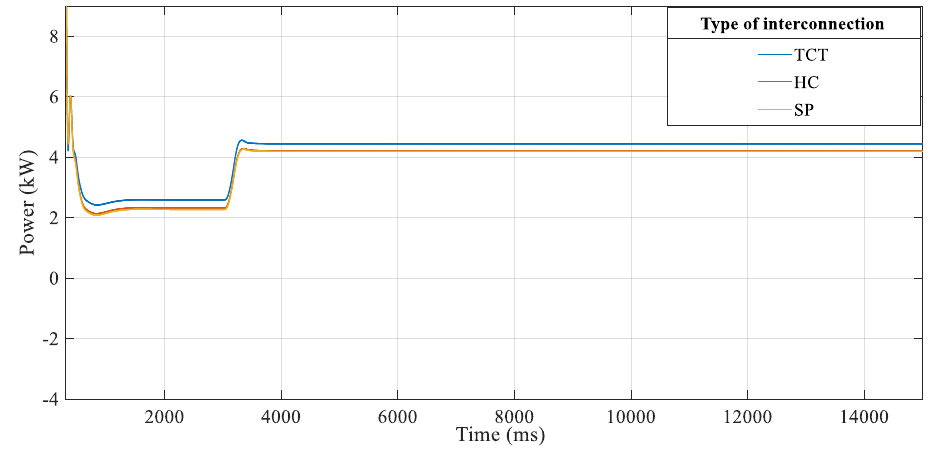
Figure 19. Impact of open-circuit fault ‘F1′ on power grid (monocrystalline PV).